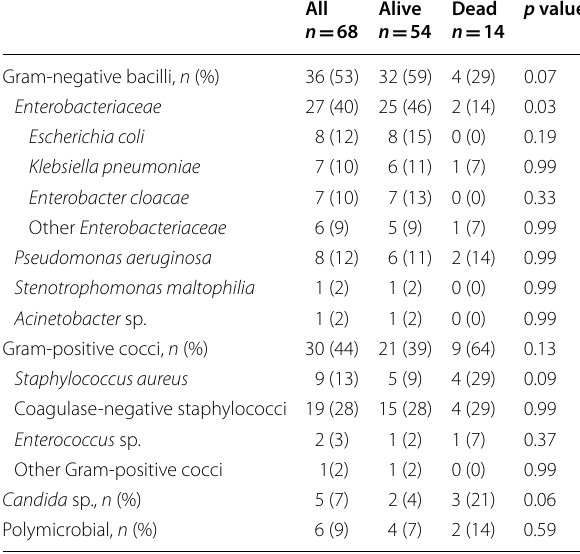
Table 2 Microbiological findings in patients with totally implanted venous